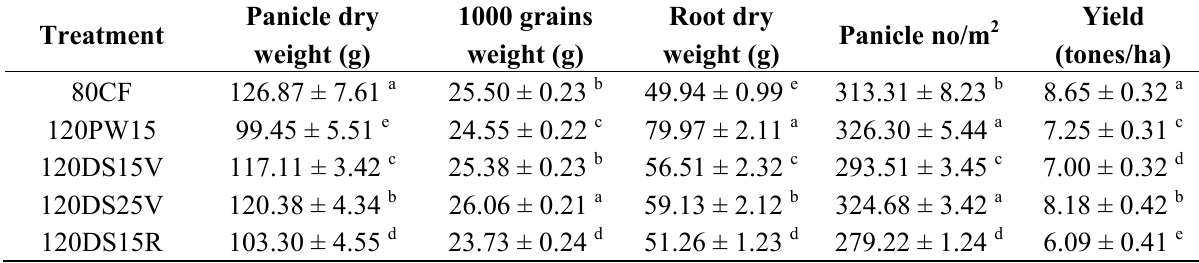
Table 1. Impact of potassium fertilization on growth and yield characteristics of rice under water stress at different growth stages. Data are means ± standard error of difference between means (SEM). N = 12. Bars represent standard error of differences between means. Means not sharing a common single letter were significantly different at p ≤